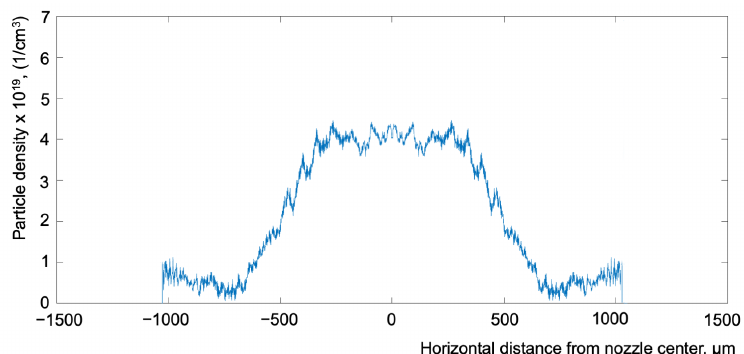
Figure 13. Horizontal distribution of the particle density at 27.1 bar and 500 µ m above the nozzle edge, 32 ms after valve opening [38].